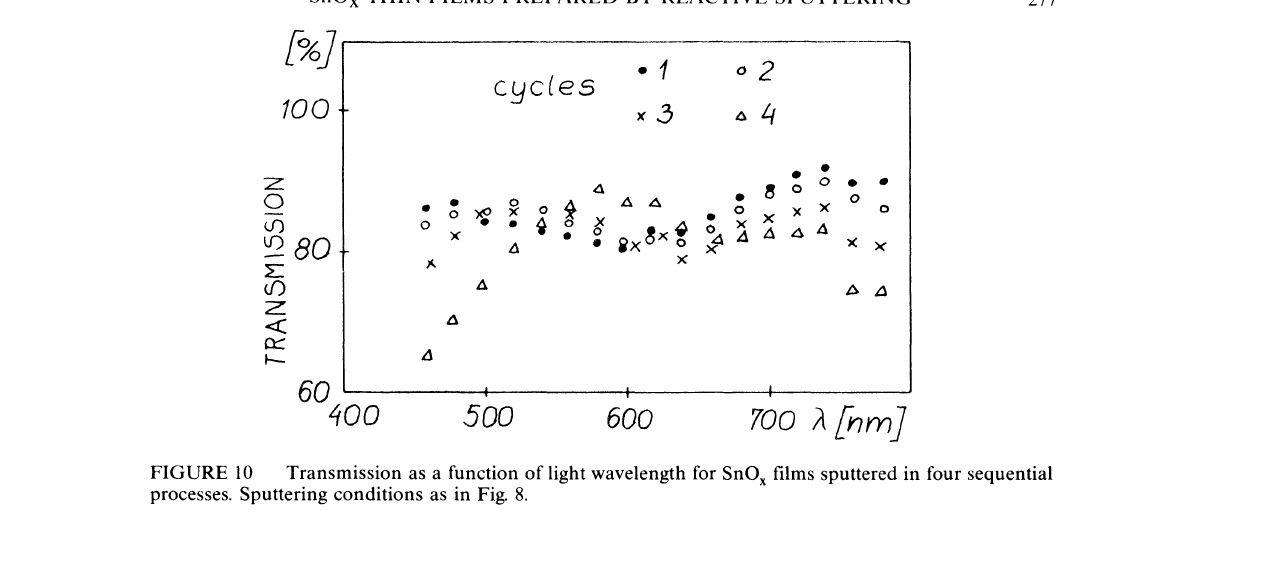
Transmission as a function of light wavelength for SnO films sputtered in four sequential processes. Sputtering conditions as in Fig. 8.